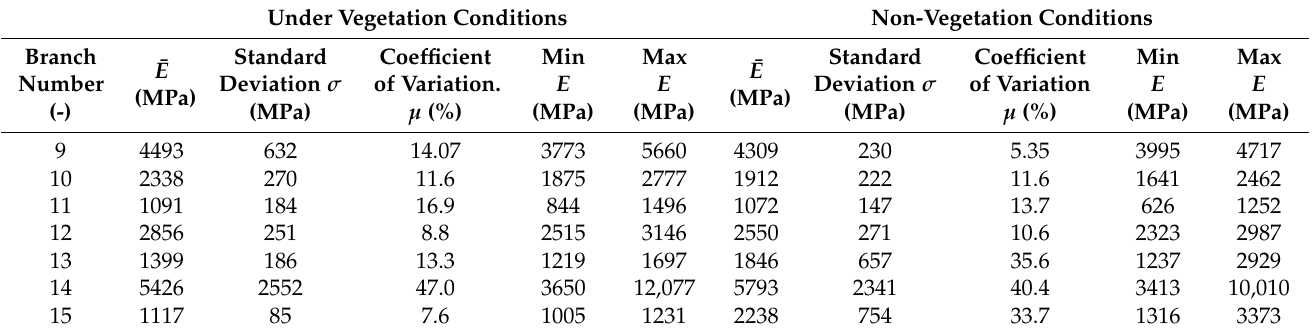
Table 7. Summary of calculated modulus of elasticity for individual branches of shrub No. 2 under vegetation and non-vegetation conditions.